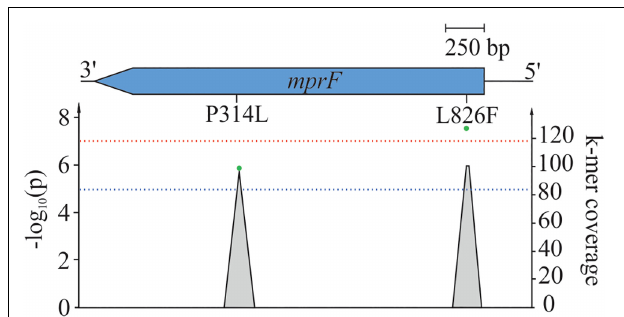
FIGURE 2 | Mapping of significant k-mers against S. aureus COL. One hundred ninety-eight significant k-mers were mapped against the reference S. aureus COL. Gray-shaded elements illustrate k-mer coverage at corresponding loci while green dots represent adjusted (lrt) p -values of mapped k-mers. The blue line indicates suggestive association ( p = 1 × 10 − 5 ), while the red line indicates the genome-wide significance threshold ( p = 5 × 10 − 8